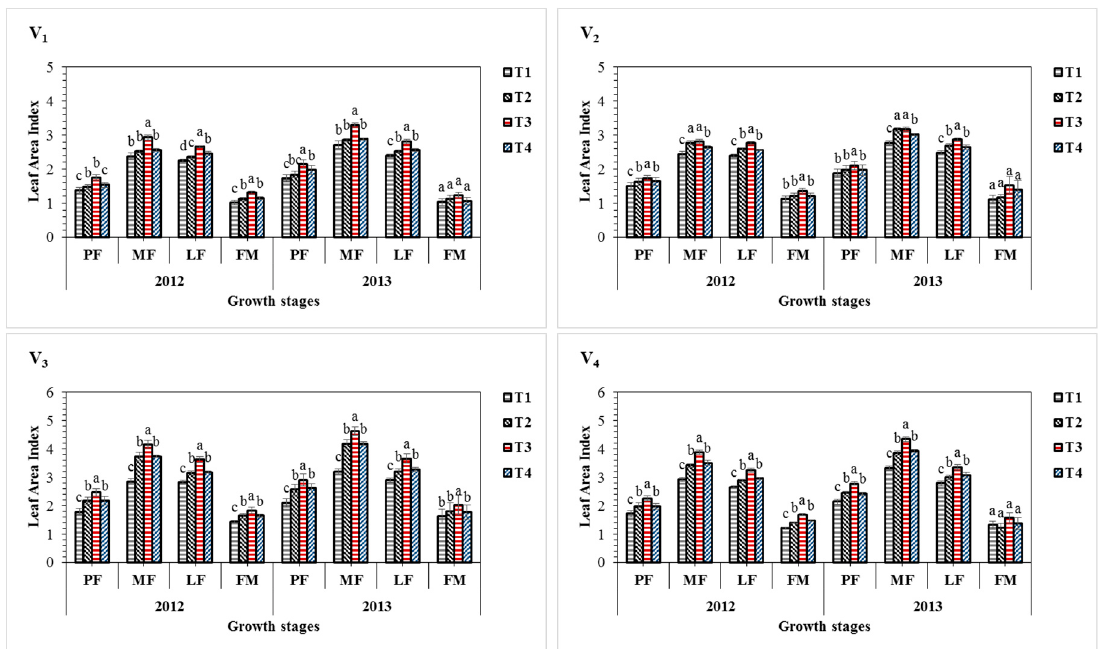
Figure 2. Variations in leaf area index (LAI) of sesame varieties as affected by sulphur treatments during 2012 to 2013 cropping season. PF, MF, LF and FM refer to four sesame growth stages pre-flowering, mid-flowering, late-flowering and full-maturity described by Langham (2007), V 1 , V 2 , V 3 and V 4 represent four sesame varieties SG-27, SG-30, SG-36 and SG-51 and T 1 , T 2 , T 3 and T 4 , represent four sulphur treatments 20, 30, 40 and 50 kg S ha − 1 respectively. All the values are average of four replicates. Bars show ± standard errors, ( n = 3). Bars with the same letter are not significantly different ( p < 0.05).